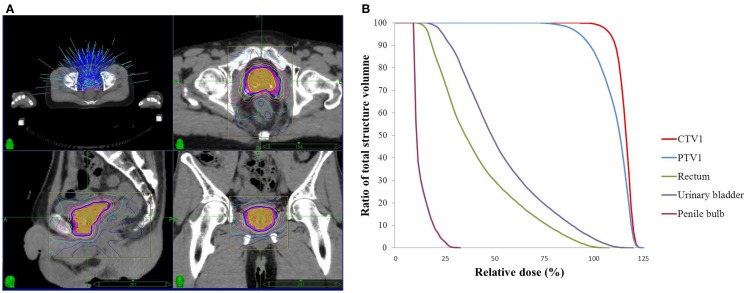
Isodose curves (A) and dose–volume histogram (B) of SBRT boost for the applied CyberKnife in the particular patient. (A) The prescription dose (21Gy), blue solid line; CTV1, orange color wash; PTV1, pink color wash.